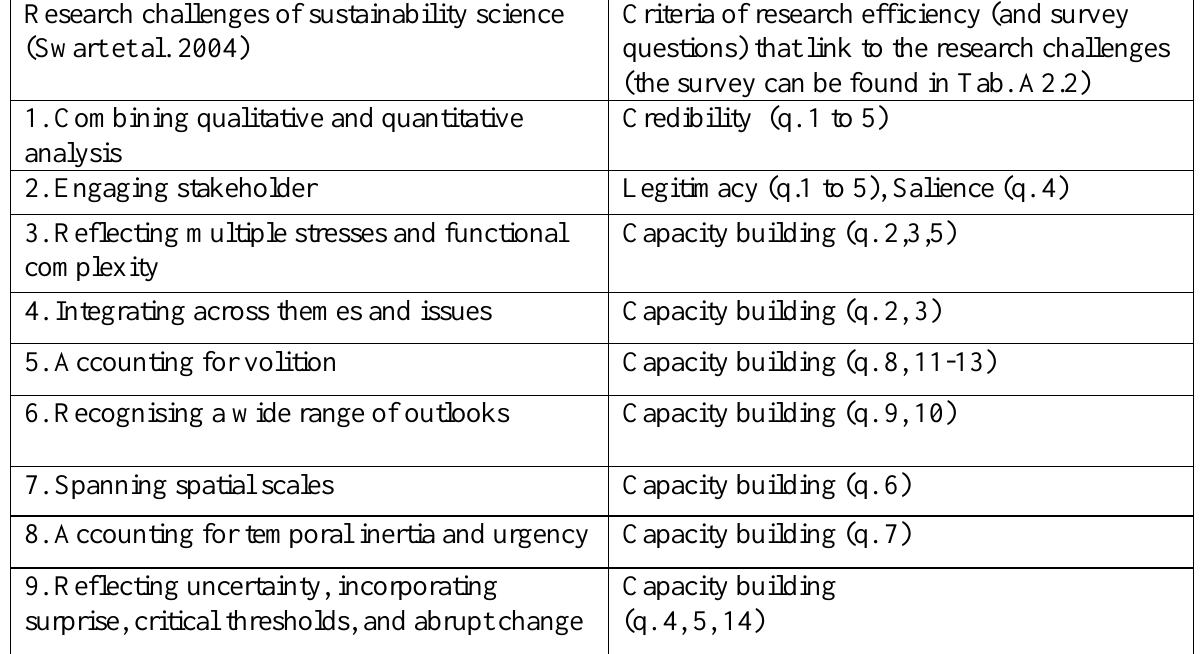
Table A3.1 : Operationalization of the nine research challenges identified by Swart et al. (2004) with survey questions related to the four criteria of research